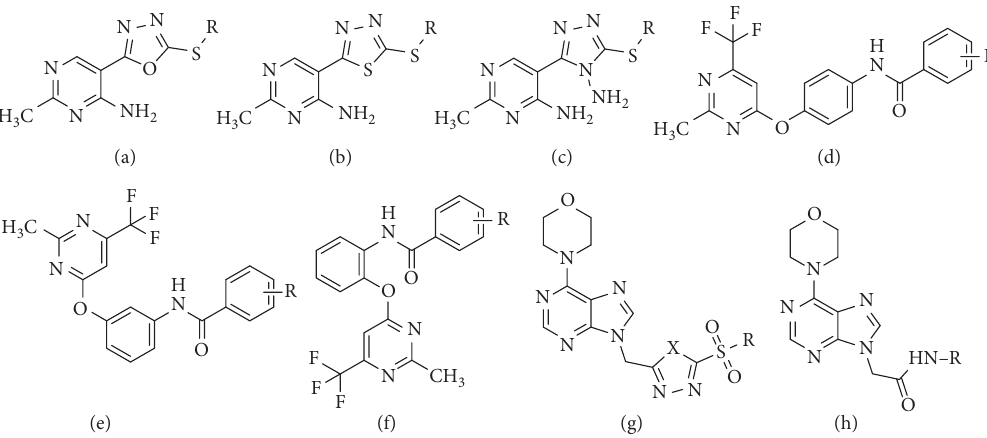
Figure 1: The structures of the pyrimidine derivatives reported in our previous work.